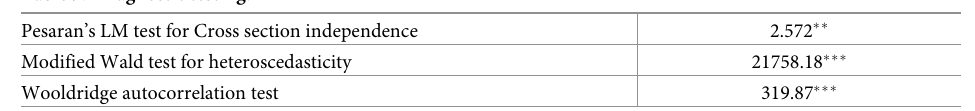
Table 9. Diagnostic testing.